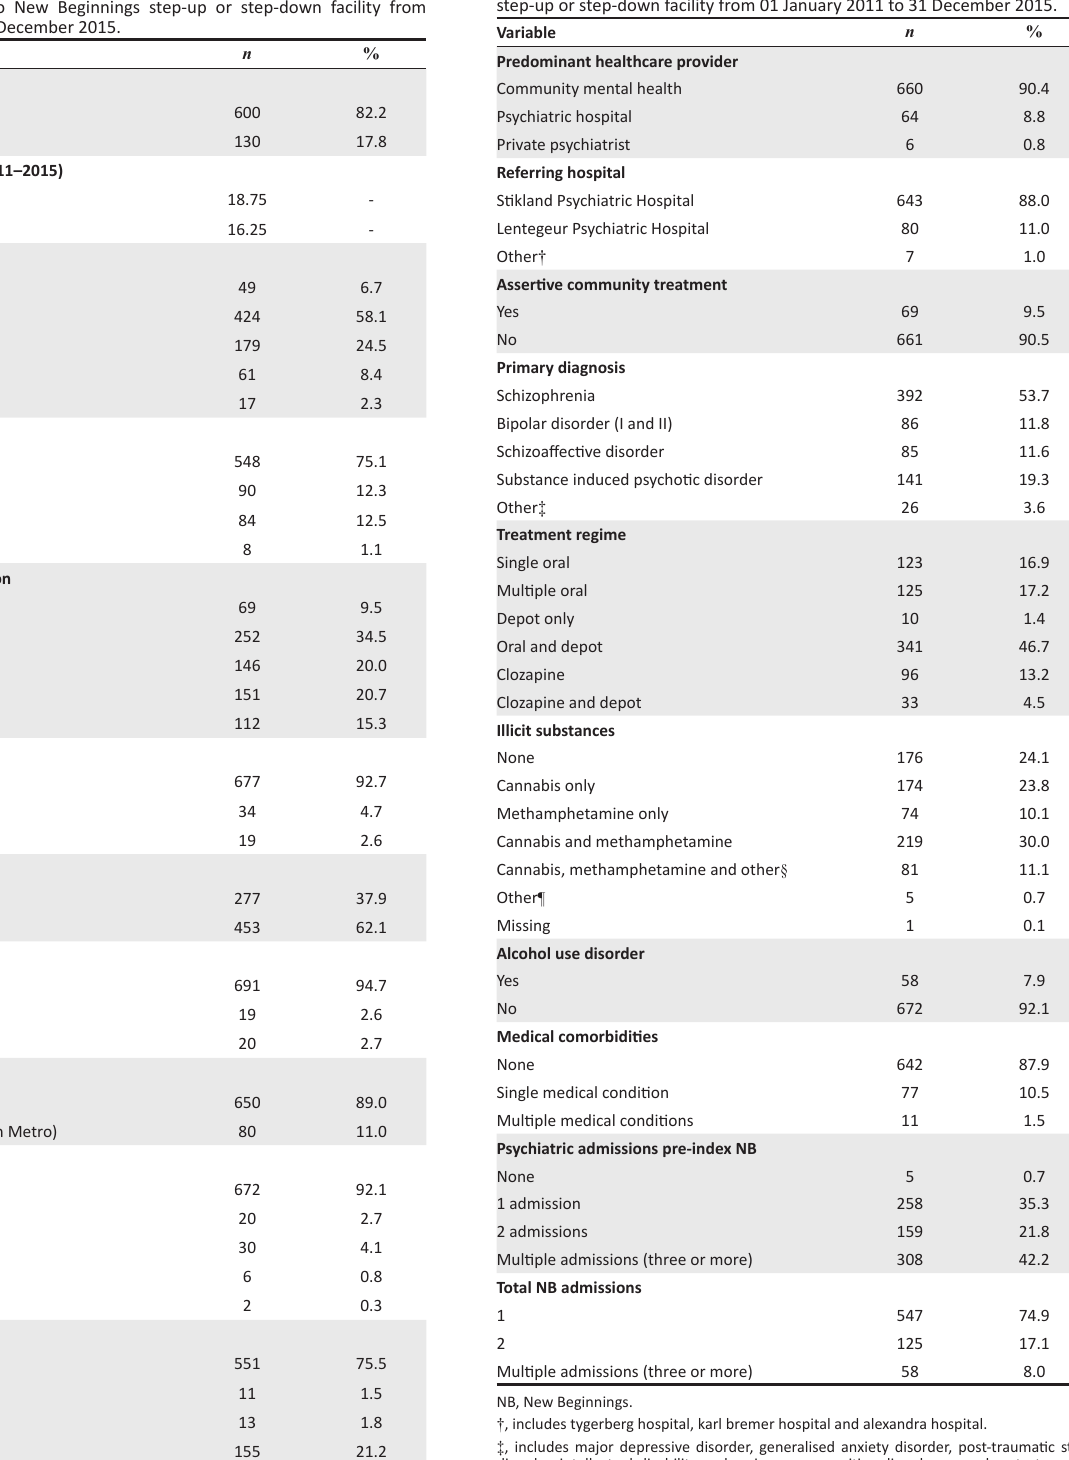
TABLE 2: Clinical characteristics of patients ( N = 730) admitted to New Beginnings step-up or step-down facility from 01 January 2011 to 31 December